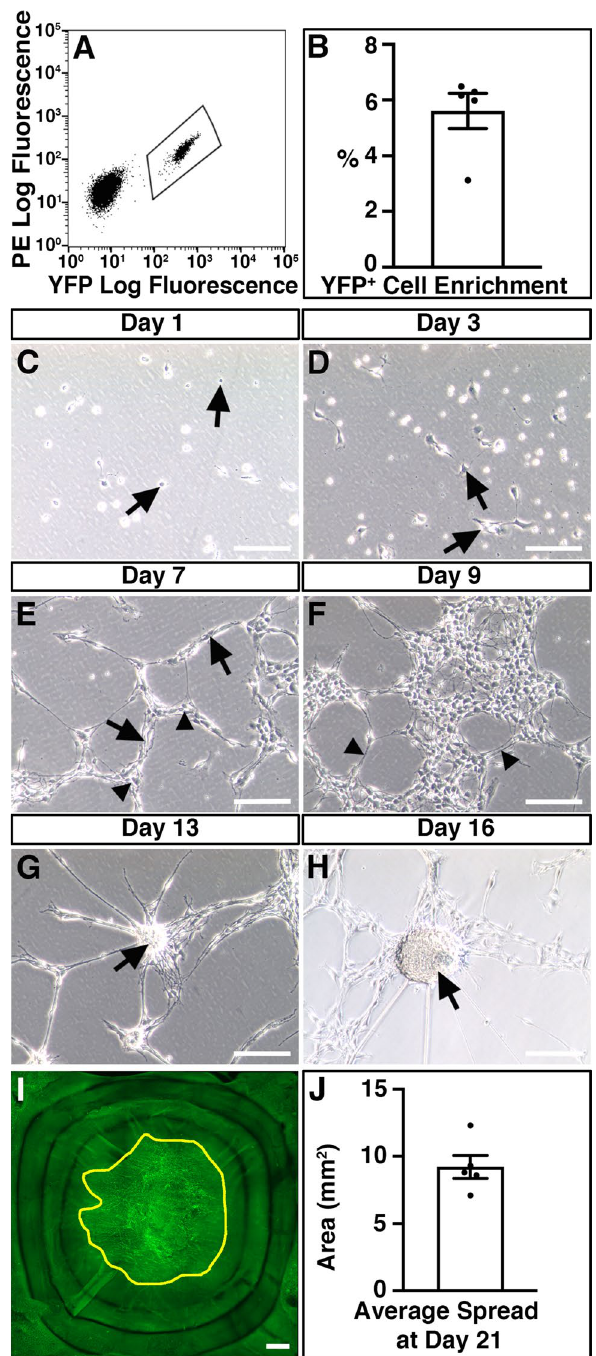
Figure 3. Isolation and expansion of donor ENSC for ex vivo transplantation. ( A ) Representative FACS profile demonstrating the gating scheme for isolation of YFP + cells (bounded area) from Wnt1 cre/ + ;R26R YFP/YFP intestine. ( B ) Summary data showing YFP + cell enrichment via FACS (n = 5). ( C – H ) Representative images showing the development of FACS-sorted YFP + cells in culture. At Day 1 ( C ), the majority of sorted YFP + cells displayed a spherical appearance (arrows). By Day 3 ( D ), YFP + cells developed a typical multipolar neural crest cell appearance (arrows). At Day 7 in culture ( E ), sorted cells appear as multipolar cell clusters (arrows) which are connected in a network-like structure (arrowheads). At Day 9 ( F ), YFP + cell clusters appeared to form extensive networks which displayed interconnecting filaments (arrowheads). Further culture to Day 13 ( G ) and Day 16 ( H ) led to the development of rounded “neurosphere” structures (arrows). ( I ) Representative montage fluorescent image showing the development of YFP + donor cells within recipient C57BL/6J colonic tissue 21-days after ex vivo transplantation. Yellow line bounds YFP + donor cell coverage. ( J ) Summary data showing average donor cell spread within recipient tissues at Day 21 (n = 5). Error bars represent mean ± s.e.m ( B , J ). Scale bars represent 250 μm ( C – H ), 50 μm ( I ). See also Supplementary Fig.